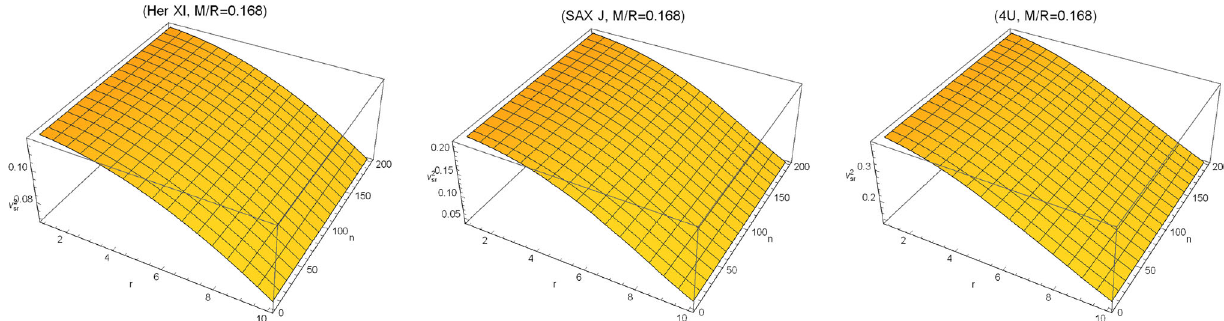
Fig. 11 Behavior of υ 2 sr with radial coordinate r (km) and model parameter n in different compact stars